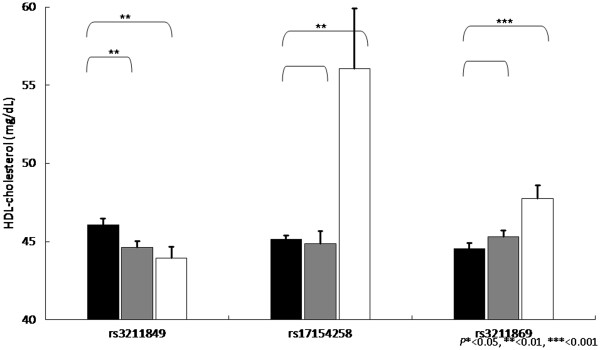
Impact of CD36 gene on HDL-cholesterol levels (mg/dL ± SE) from pairwise genotype comparisons. Adjusted mean HDL-cholesterol for non-carriers (black bars), for heterozygous (gray bars) and subjects homozygous for the minor allele (white bars). Sample sizes (n for non-carriers, heterozygous, and homozygous subjects for SNP (rs3211849), n = 383, 408, 119, for SNP (rs17154258),n = 813, 94, 4, and for SNPs (rs3211869), n = 463, 363, 84, resulting co-dominant P-values as 0.006, 0.017 and 0.002.